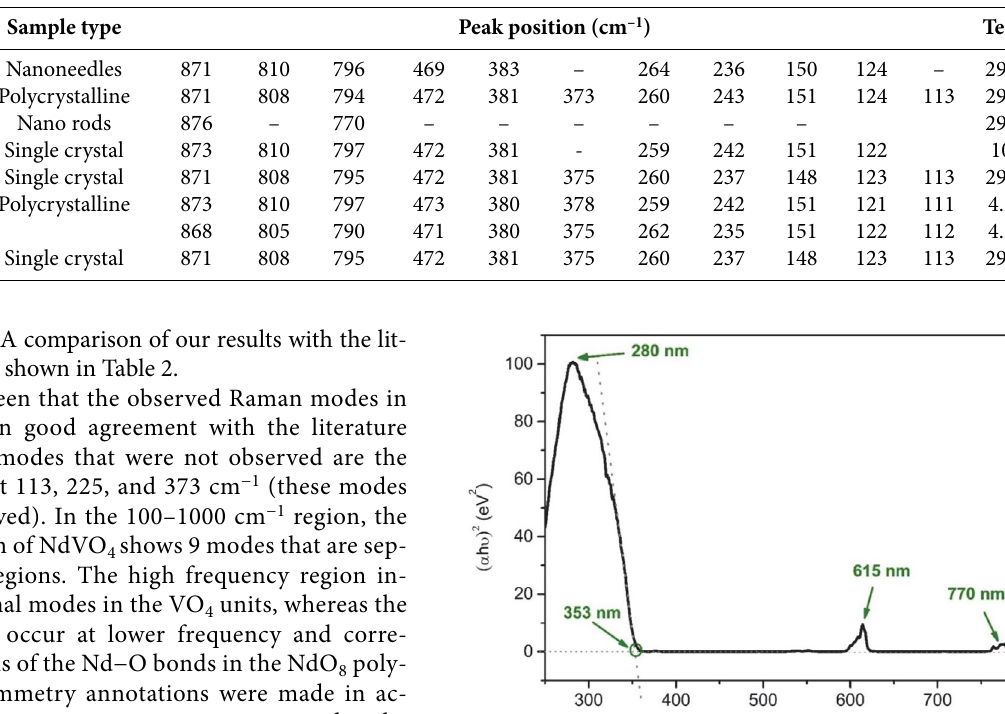
Table 2. The Raman modes of NdVO 4 reported in the literature and the Raman modes observed in this study.